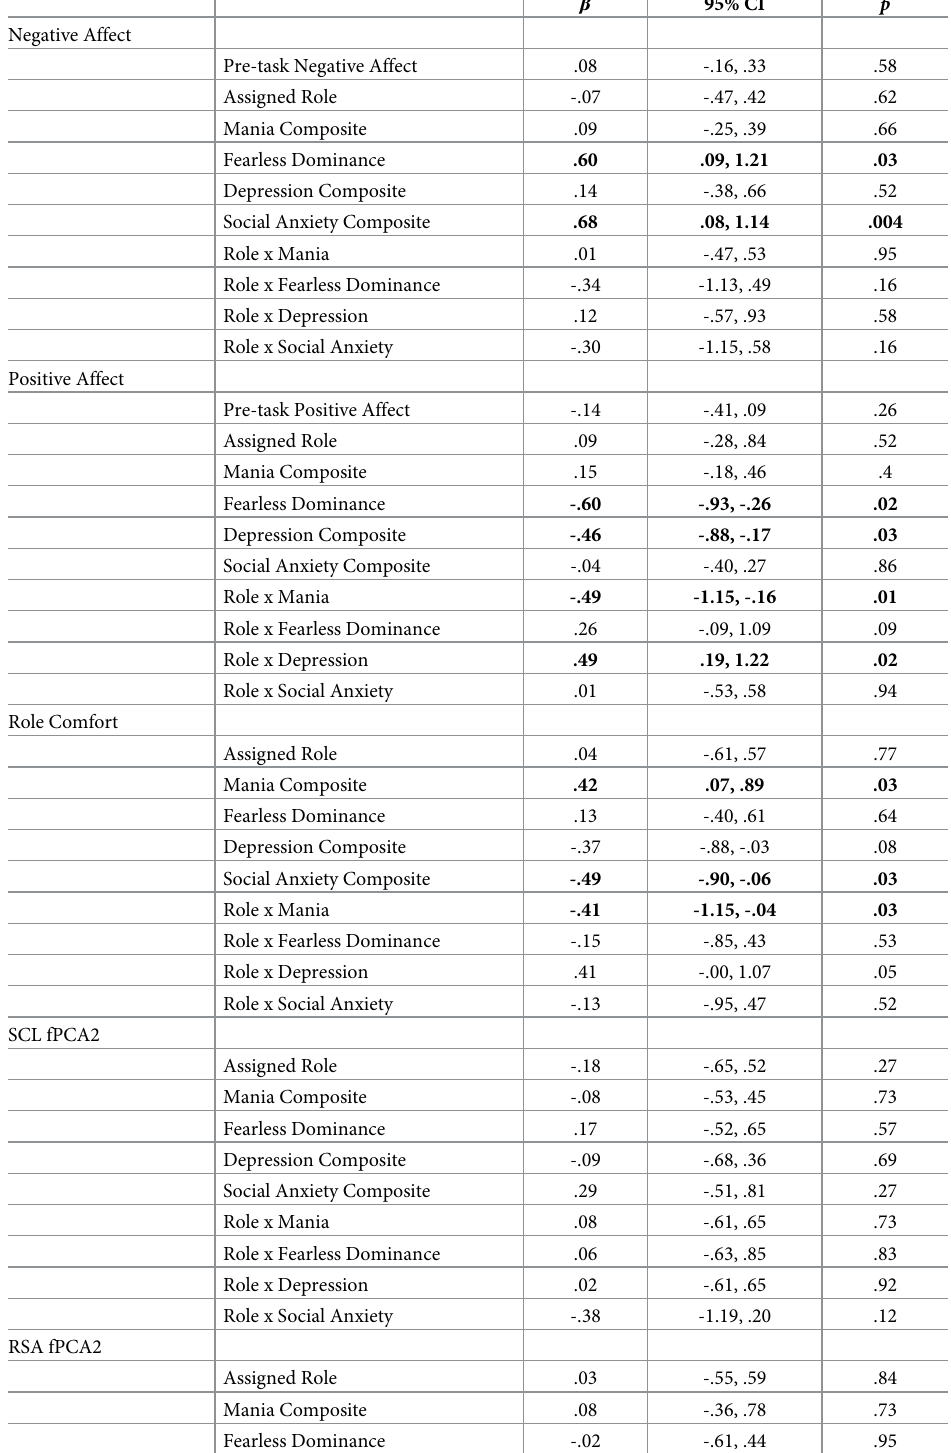
Table 2. Multiple regression models of role, psychopathology tendencies, and their interactions on negative affect, positive affect, role comfort and psychophysiological variables.